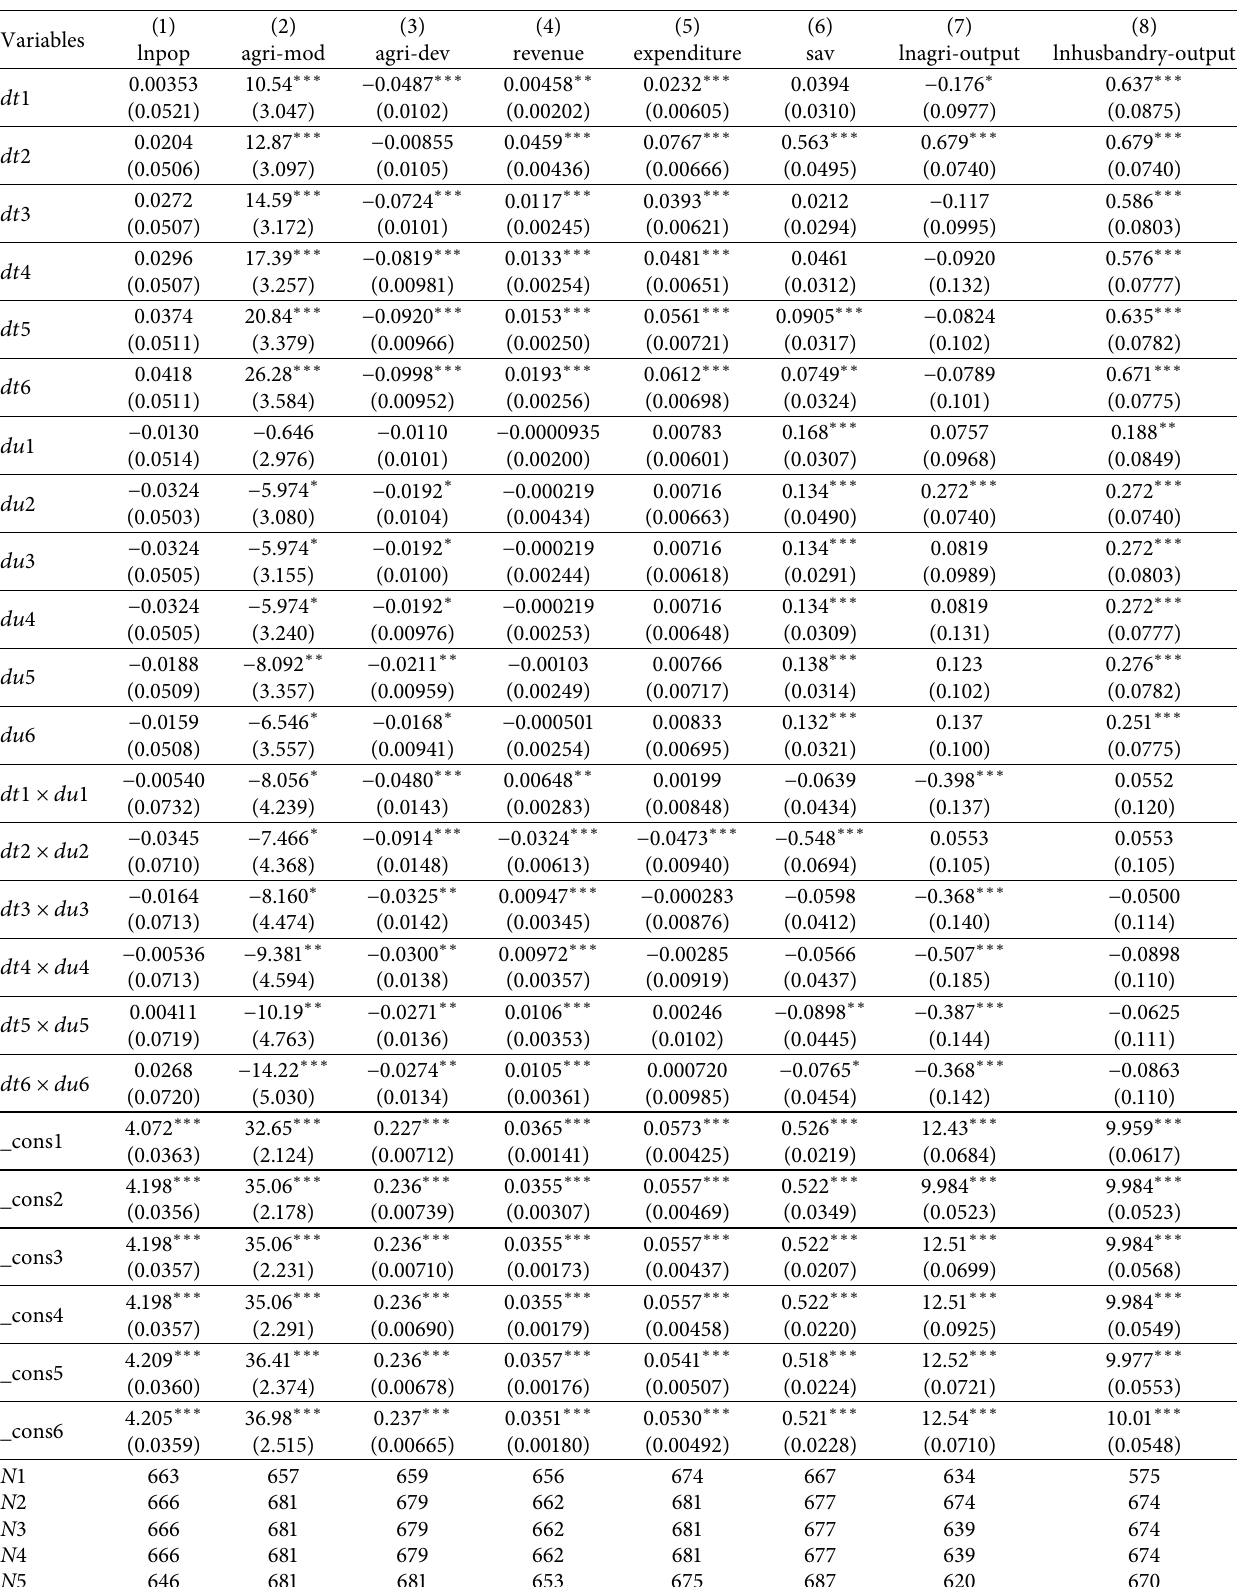
Table 6: PSM-DID dynamic test results of TCID impact